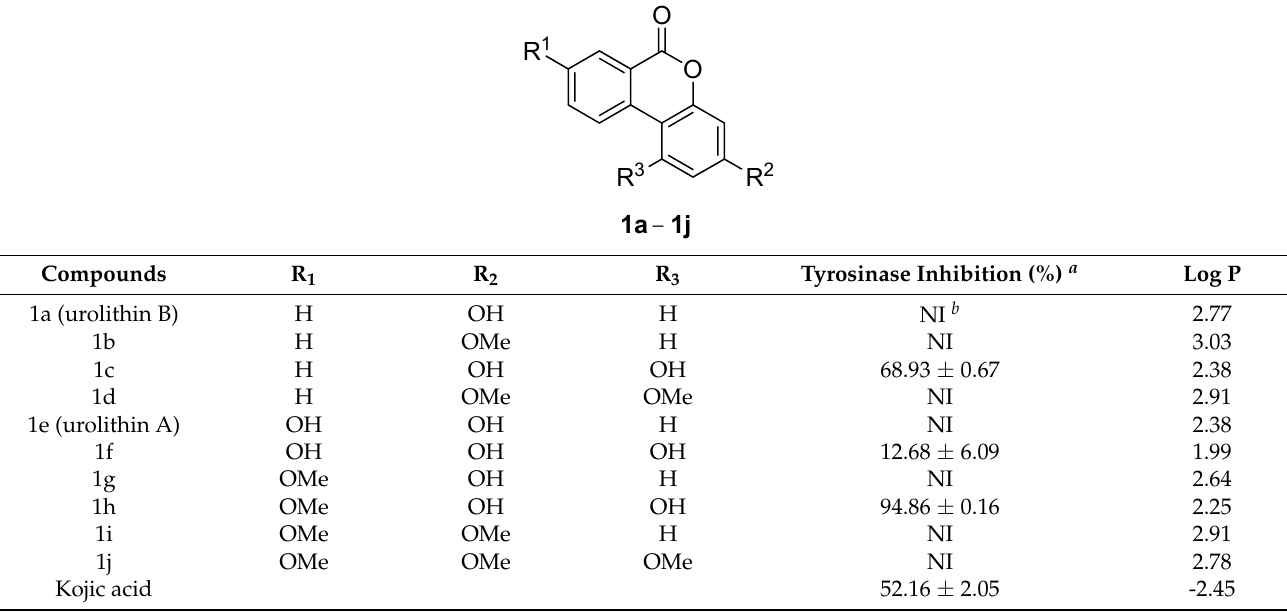
a Tyrosinase inhibition was examined for all compounds at 50 μ M using L-tyrosine as a substrate. b NI means no inhibition. Results shown are mean ±